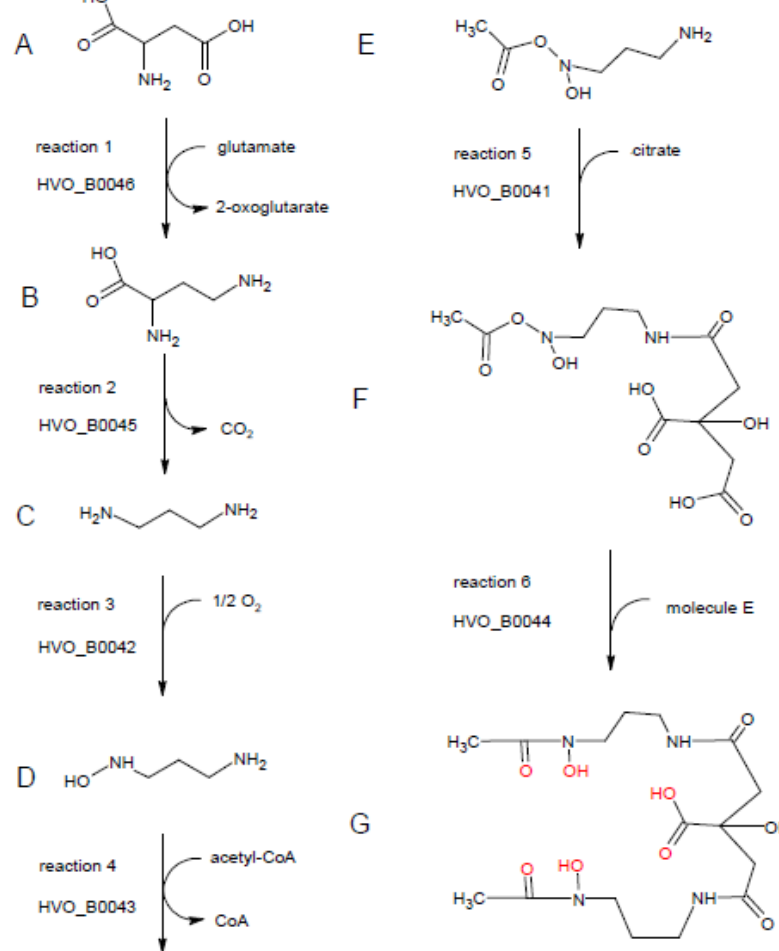
Figure 8. Putative enzymatic activities of HVO_B0041–HVO_B0046 and proposed biosynthetic pathway of Schizokinen. The substrate, intermediates, and the product are denoted with letters from A to G. The reactions are numbered and the corresponding enzyme designation is shown. For details, see text. The graphic was produced with ChemSketch (www.acdlabs.com).